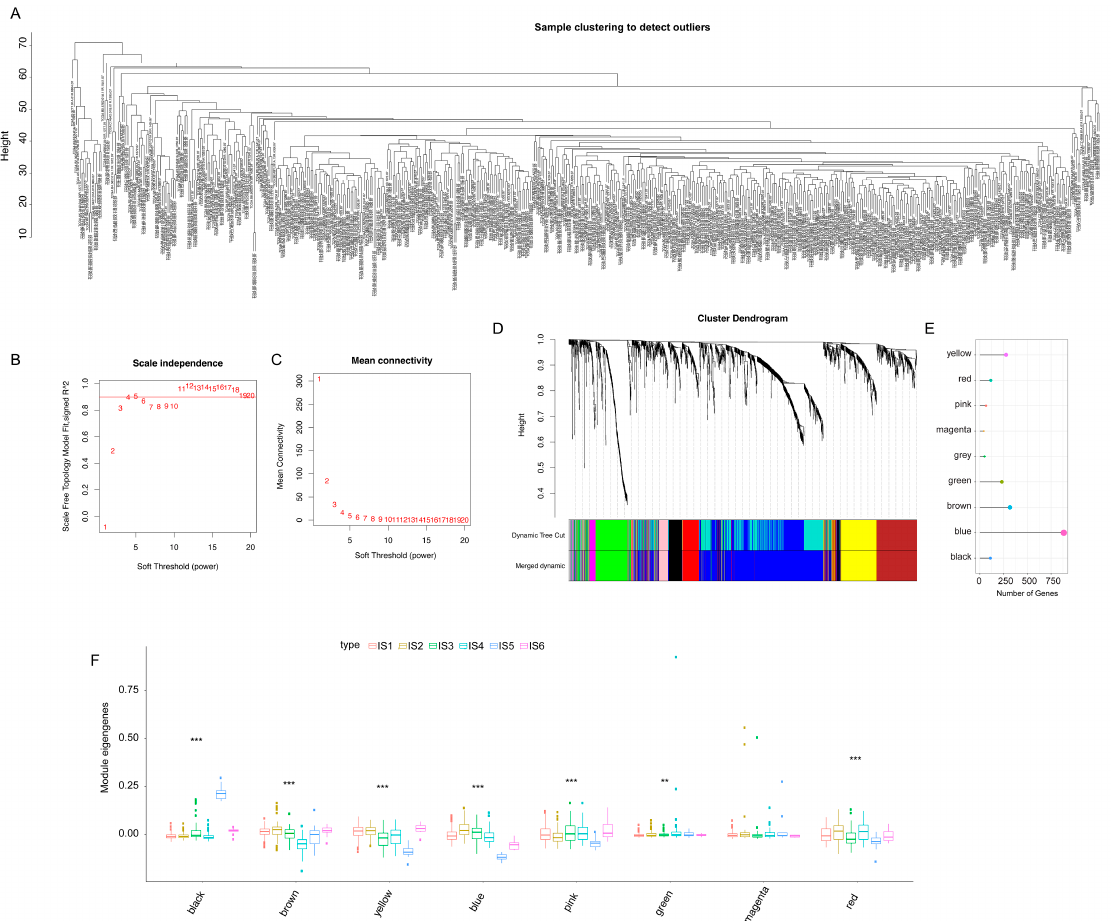
Figure 10. Identification of co-expression modules of immune genes in KIRC. ( A – D ) Gene co-expression network analysis based on immune-related genes in KIRC. ( A ) Sample clustering. ( B ) Scale-free fit index. ( C ) Mean connectivity. ( D ) Dendrogram of all differentially expressed genes. ( E ) Gene numbers of co-expressed modules. ( F ) The distribution of the six immune subtypes in the eigengenes of eight modules. Kidney renal clear cell carcinoma (KIRC). (** p < 0.01, *** p < 0.001).